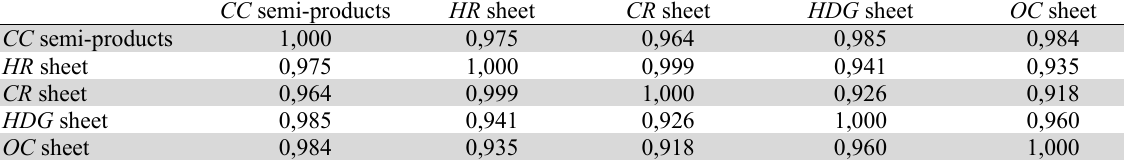
Correlation matrix for the prices of the analyzed products and CC semi-products CC